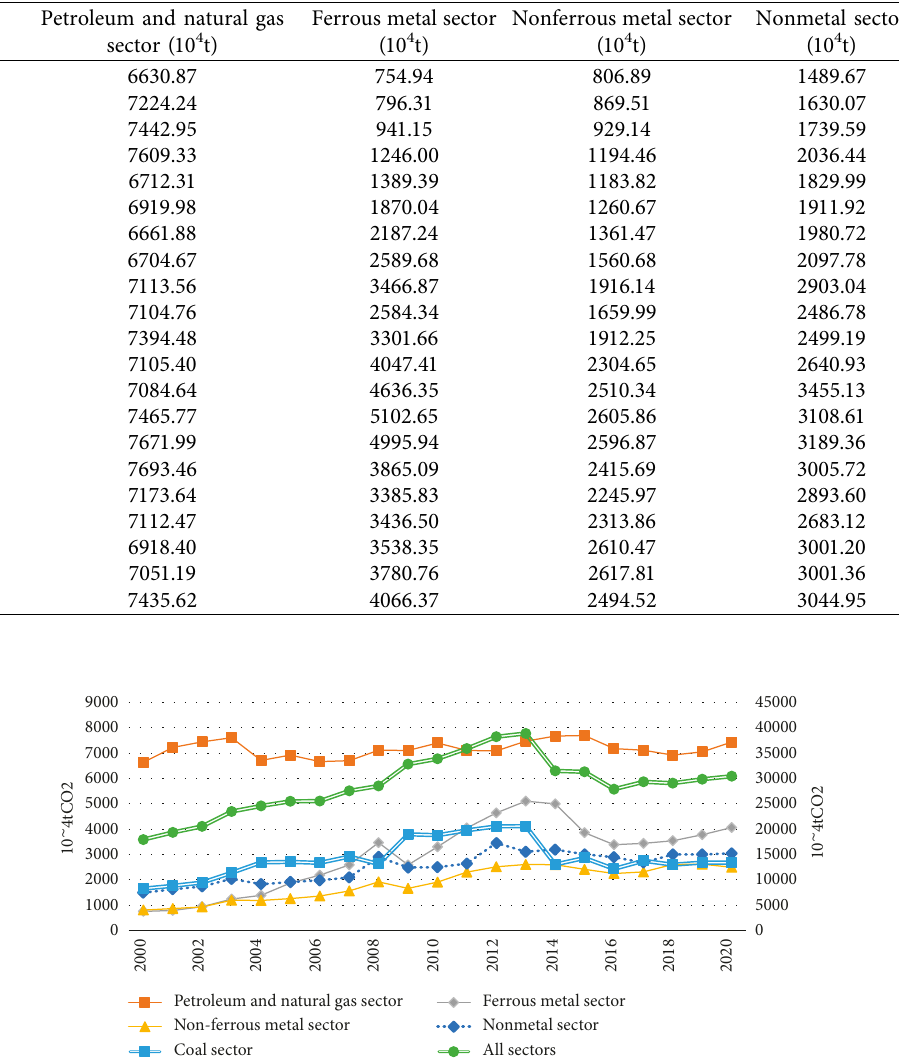
Figure 6: Carbon emissions of China’s mining industry and subsectors from 2000 to 2020. Note . In Figure 6, the value of coal sector and all sectors adopts the right longitudinal axis coordinates, and the other values are the left longitudinal axis